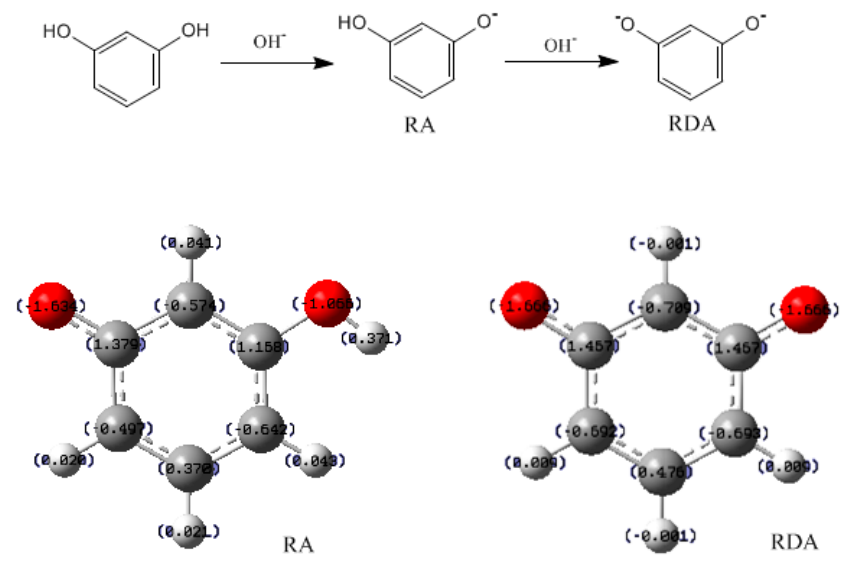
Figure 2. The calculated atomic charges for resorcinol anion (RA) and dianion (RDA).